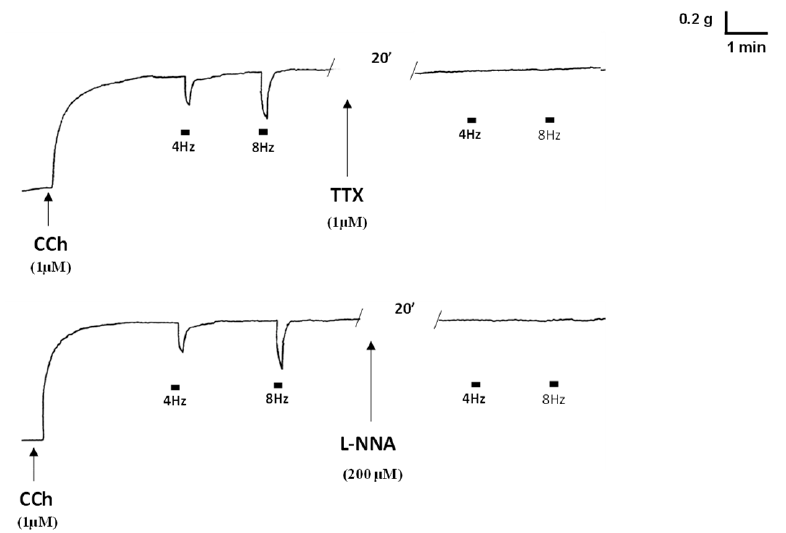
Figure 1. Effects of TTX and L-NNA on the EFS-induced inhibitory responses in CCh-precontracted gastric strips. Typical tracing showing the relaxant responses obtained at 4 and 8 Hz stimulation frequencies in carbachol (CCh)-precontracted strips and in the presence of 1 µ M guanethidine (upper and lower left-hand traces) in strips from the mouse gastric fundus. Note the abolition of the electrical field stimulation (EFS)-induced inhibitory responses at both stimulation frequencies following the addition of tetrodotoxin (TTX) (upper right-hand trace) or the nitric oxide (NO) synthesis inhibitor L-N G -nitro arginine (L-NNA) (lower right-hand trace) to the bath medium.